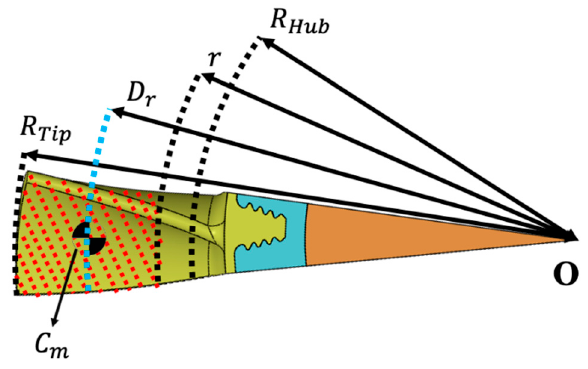
Figure 3. Schematic diagram of a part of rotor blades.